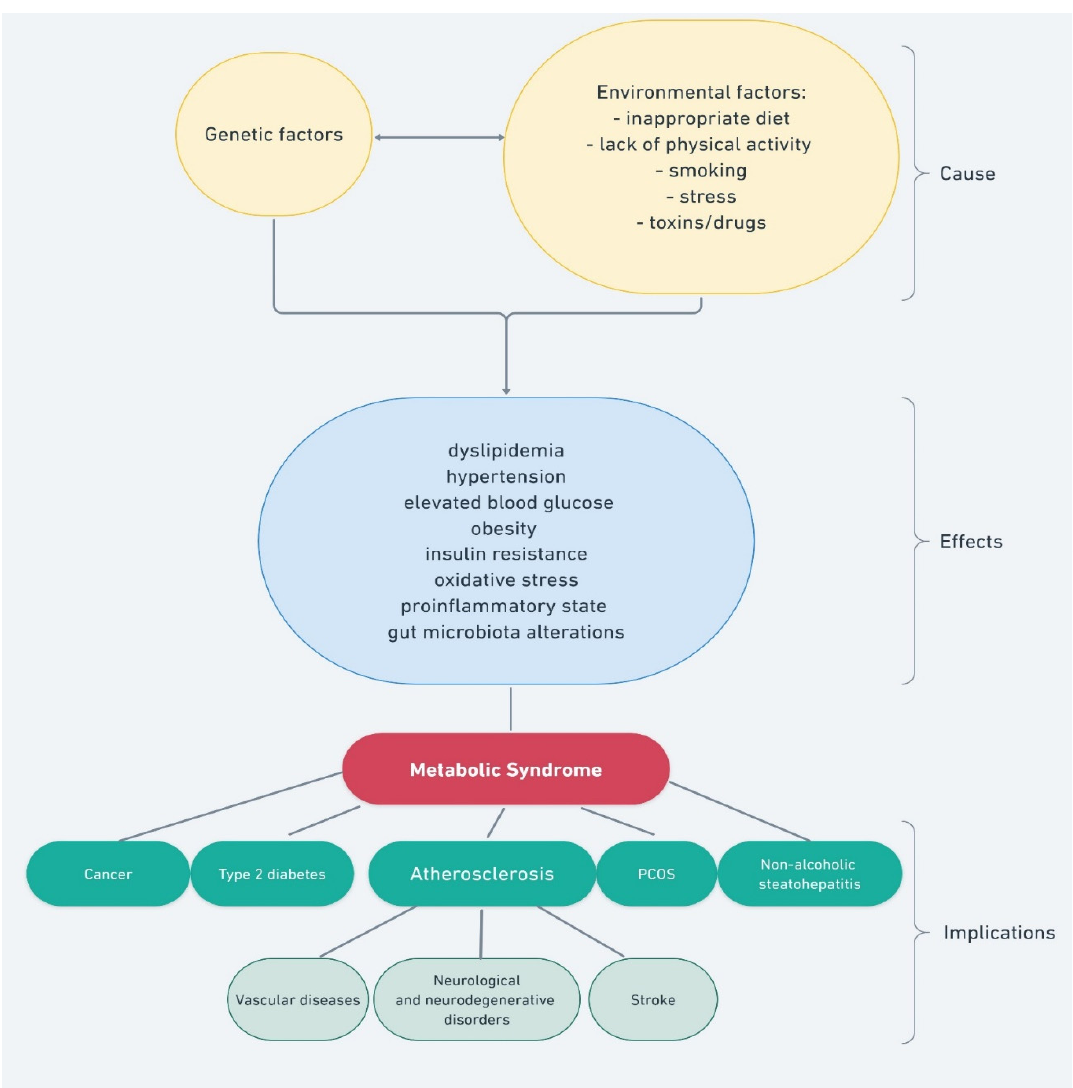
Figure 1. Factors and processes that impact the development of the metabolic syndrome.